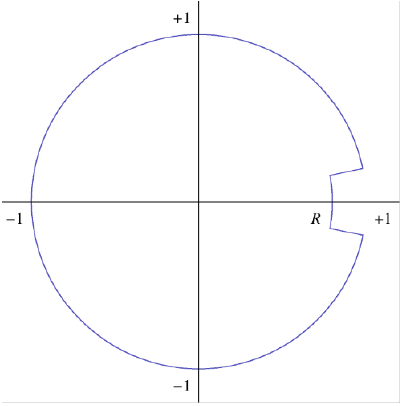
Figure 1. The contour σ